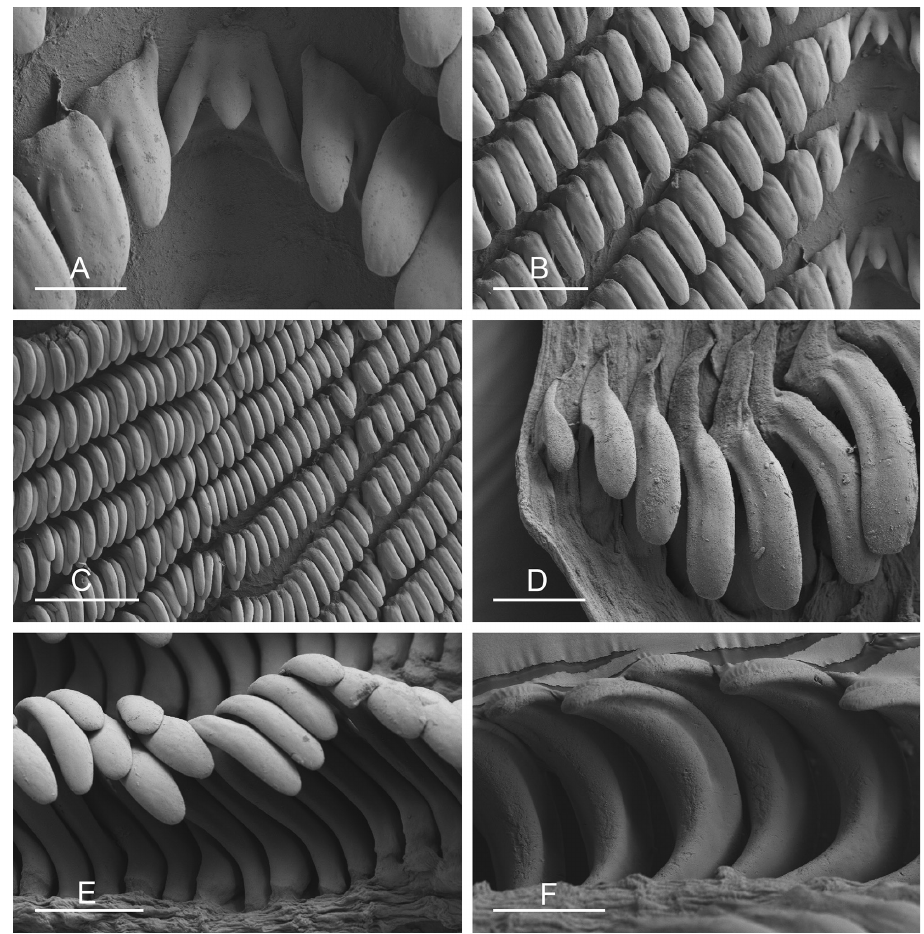
Figure 62. Radula, Wallaconchis melanesiensis , Vanuatu [5484] (IM-2013-62406). A Rachidian and innermost lateral teeth, scale bar 20 μm B Rachidian and inner left lateral teeth, scale bar 50 μm C Tran- sition between inner lateral teeth and outer lateral teeth, scale bar 100 μm D Outermost lateral teeth, scale bar 20 μm E Hook of left lateral teeth from underneath, without basal lateral spine, scale bar 30 μm F Hook of left lateral teeth from underneath, without basal lateral spine, scale bar 20